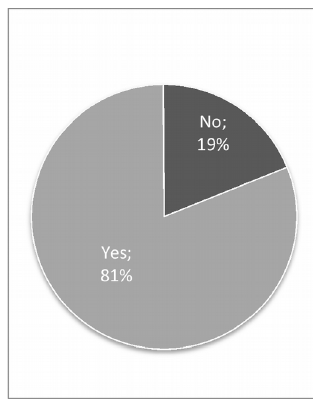
Figure 4. The training received has met expectations Figure 5. Recommends the training